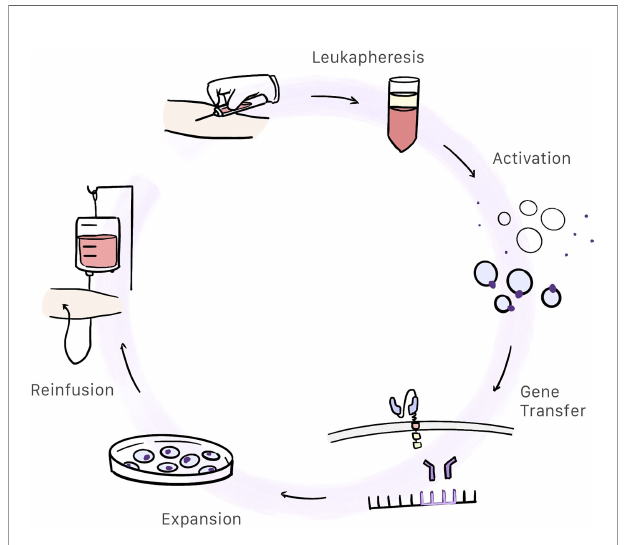
FIGURE 3 | Patient whole blood is extracted and centrifugated in order to obtain the white blood cells. Then T-cellsare selectedand activated. Afterwards, gene transfer containing the CAR information isinsertedinto the activated T-cells genome resulting inthe creation ofCAR-T cells. These cellsare expandedand after a quality control,are reinfunsed into the